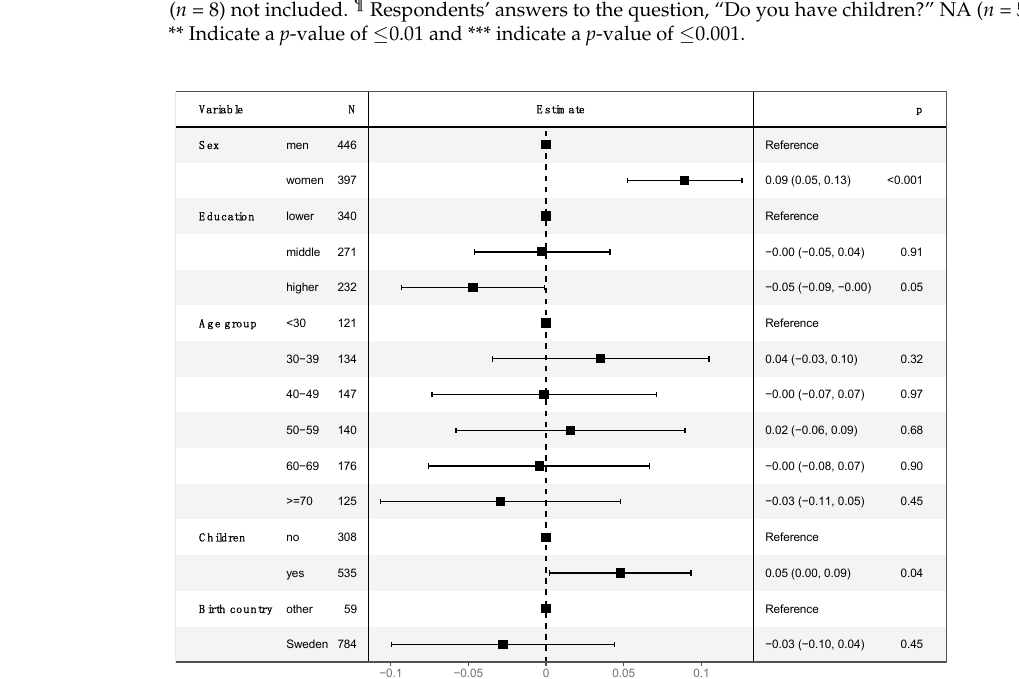
Figure 1. Multivariable linear regression of log-transformed 6-item CWS score in respondents without personal cancer history. The model is adjusted for sex (men/women), education level (lower, middle, higher), age group (<30 years/30–39 years/40–49 years/50–59 years/60–69 years/>69 years), children (yes/no), and country of birth (Sweden/other). The outcome of 6-item CWS score